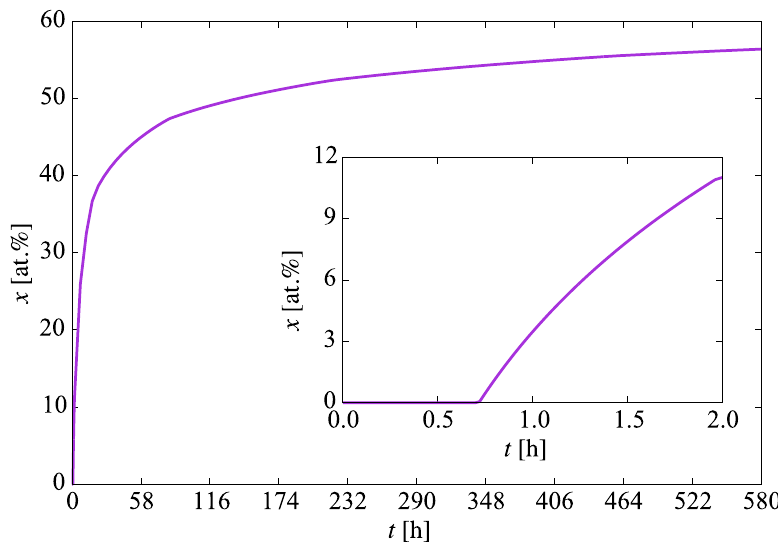
Figure 5. Evolution with time of the hydrogen concentration at the oxide/metal interface. This represents the boundary condition for the spatially-resolved SCD calculations of hydride nucleation and buildup.